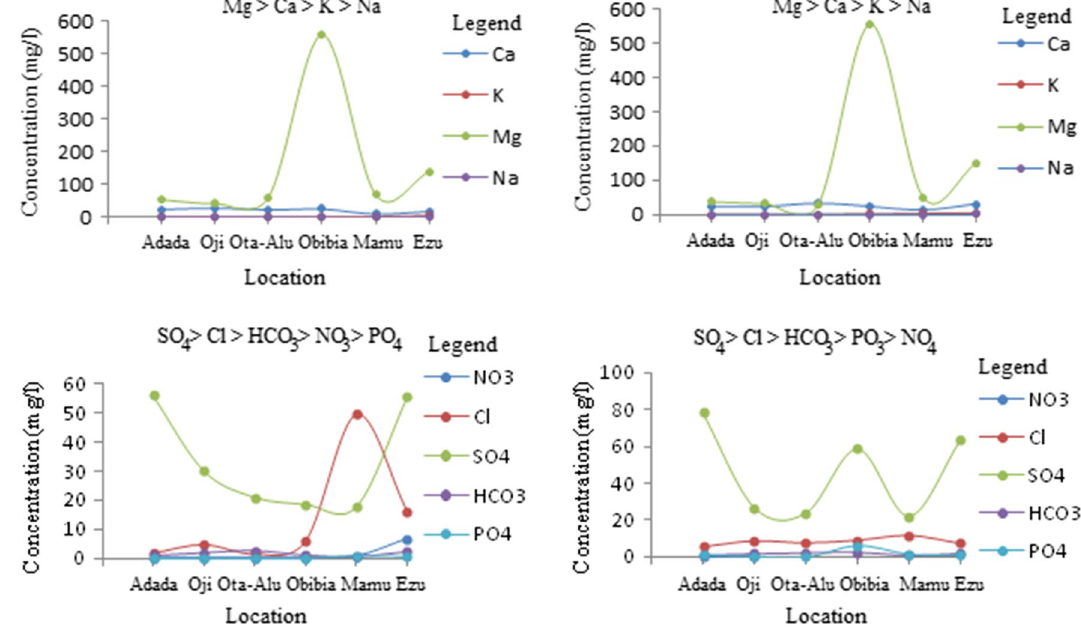
Fig. 5 Order of geochemical